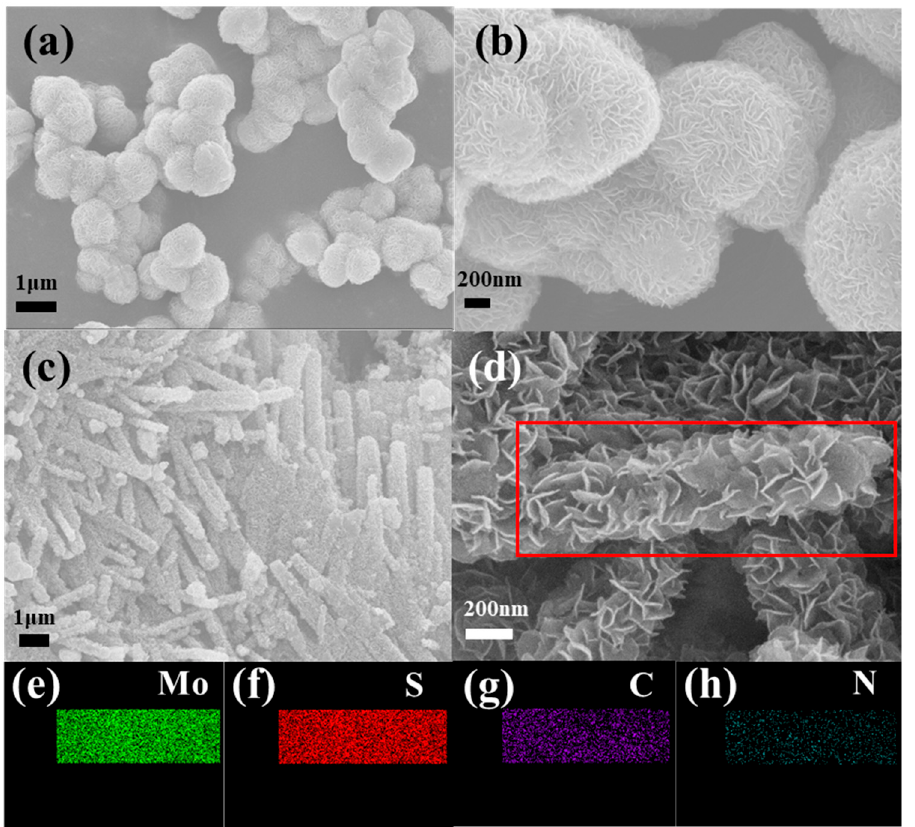
Figure 3. SEM images of ( a , b ) pure MoS 2 and ( c , d ) FR-MoS 2 /PPy composite; EDS mapping analysis of ( e ) Mo, ( f ) S, ( g ) C, and ( h ) N.